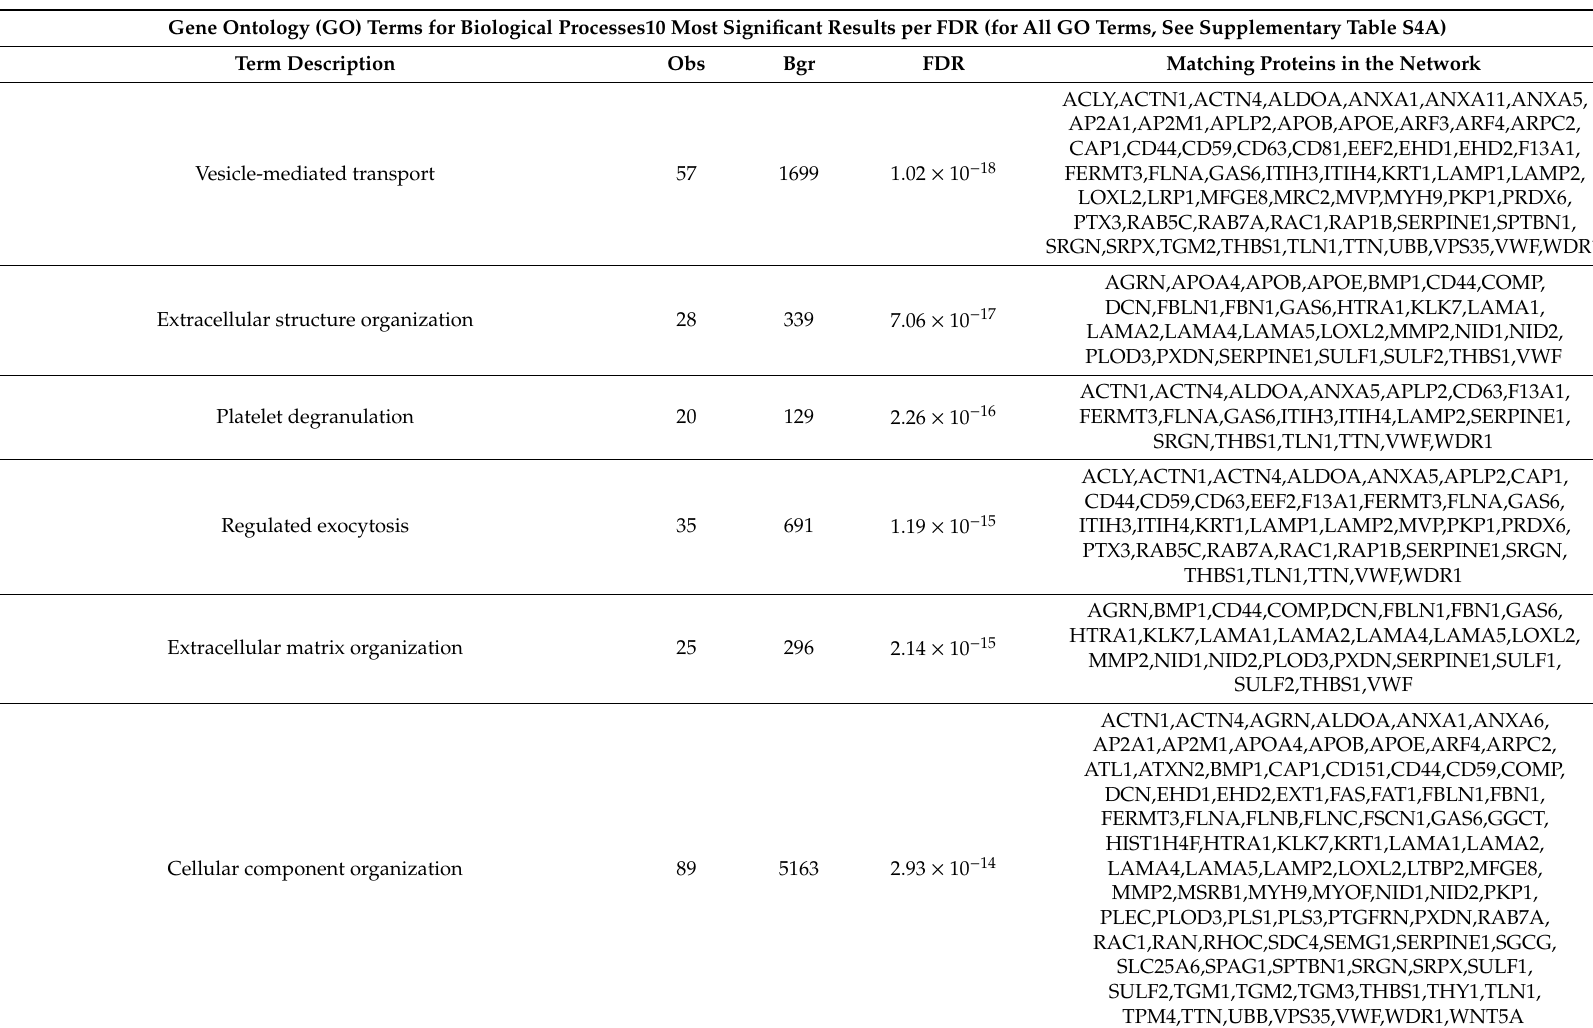
Table 8. Biological processes, KEGG pathways, and PMIDs for the EV total unique proteins in the HIV group for the control vs. HIV comparison. Gene Ontology (GO) Terms for Biological Processes10 Most Significant Results per FDR (for All GO Terms, See Supplementary Table